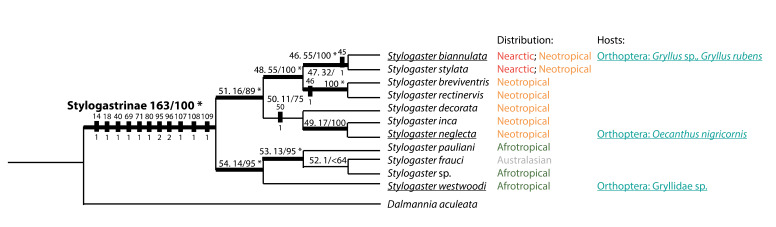
Phylogenetic tree modified from Gibson et al. (2012). Most-parsimonious cladogram generated from combined molecular and morphological data, see Gibson et al. (2012) for details. Host and biogeographical information added. Stylogaster with confirmed hosts underlined. Biogeographical information from Stuke (2017) and host information from Table 3.